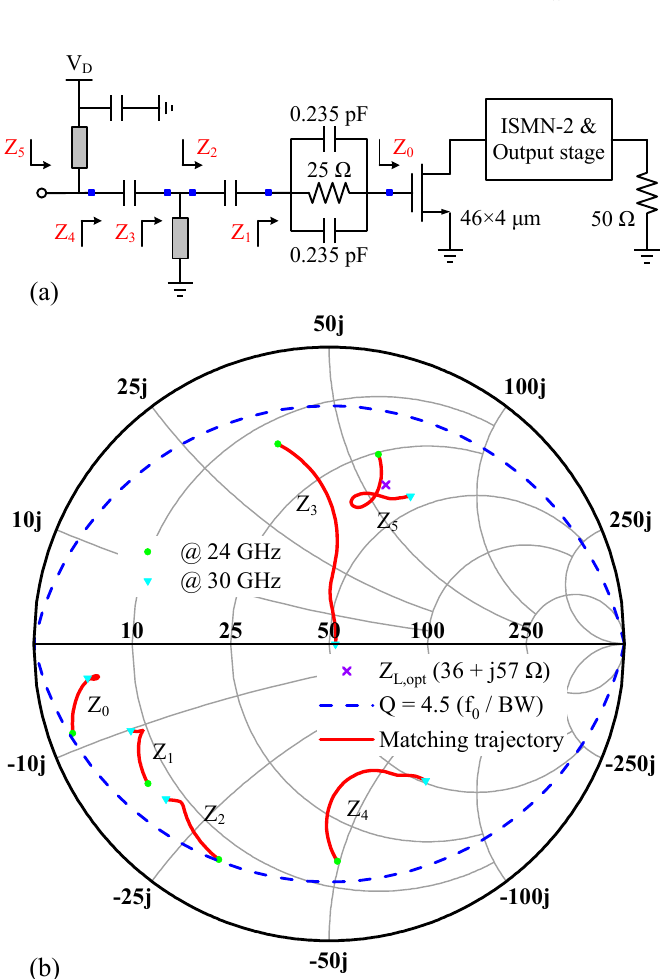
Figure 11. ( a ) Schematic of the ISMN-1. ( b ) Matching trajectory along the ISMN-1 within the 24–30 GHz bandwidth.